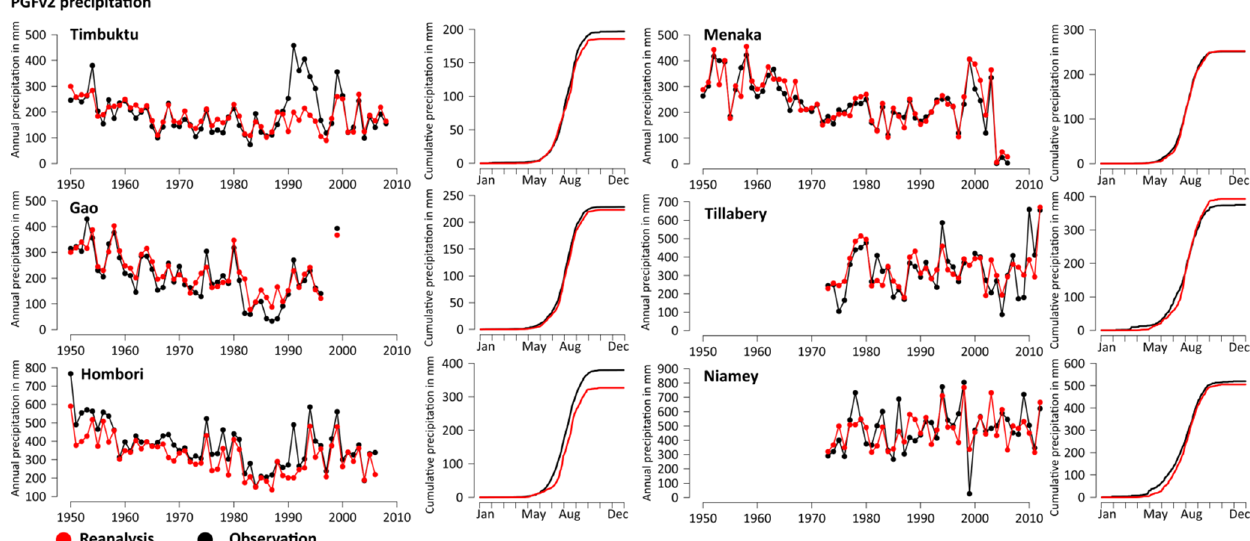
Figure 4. Comparison of precipitation from interpolated PGFv2 reanalysis data (red) with observations from six weather stations (black) in the research area. For each station, the annual precipitation ( left ) and the cumulative sum of the precipitation of the whole period ( right ) is